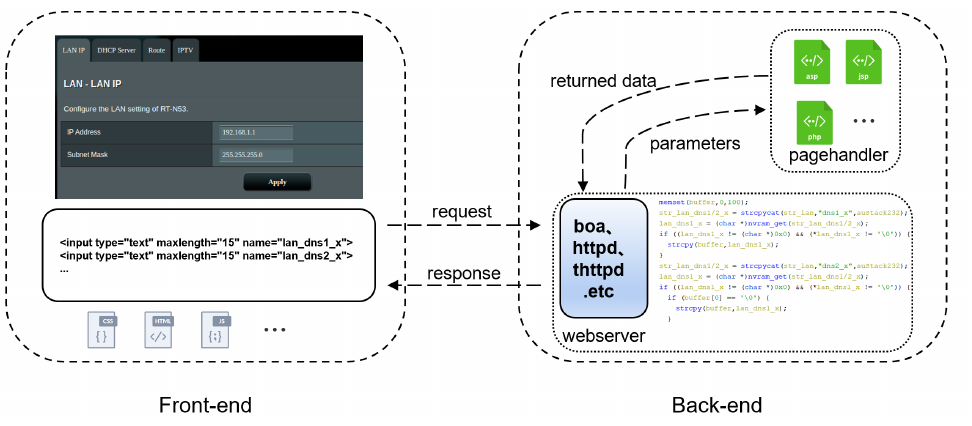
Figure 2. The request processing process of the web service in ASUS RT-N53